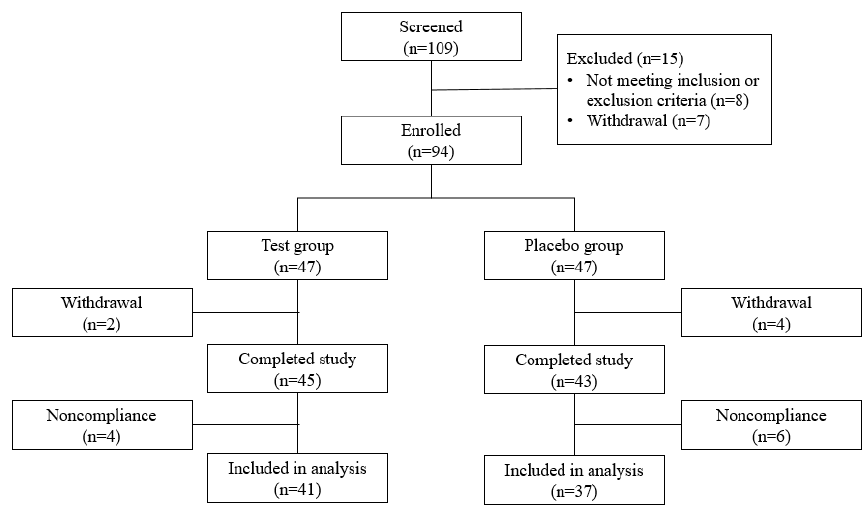
Figure 2. Flowchart illustrating the inclusion and exclusion of the study subjects.